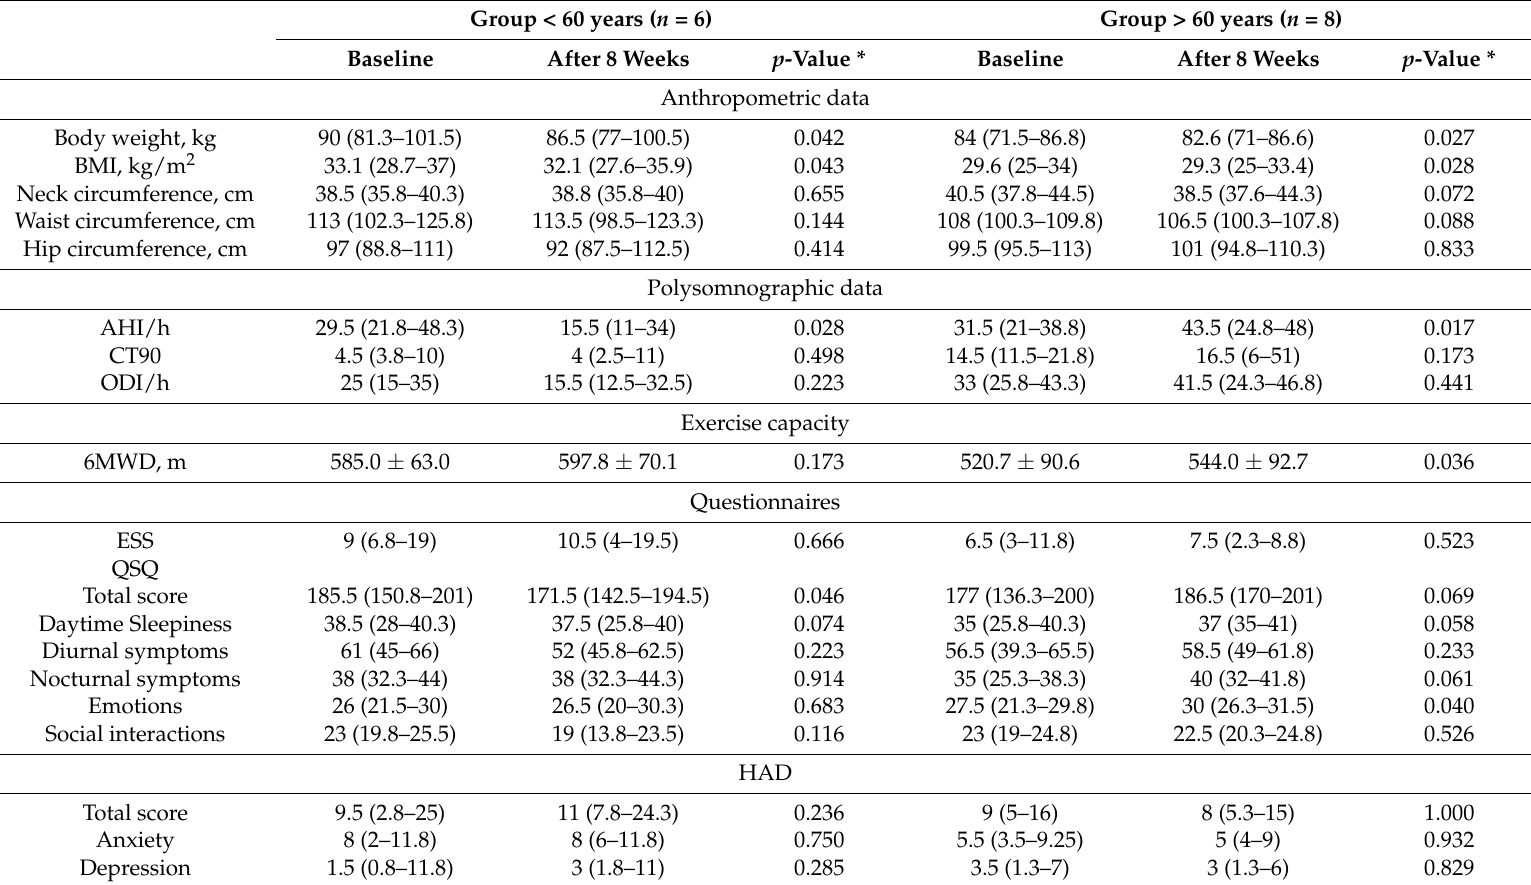
Table 3. Effects of combined intervention, analyzed by age (i.e., younger or older than